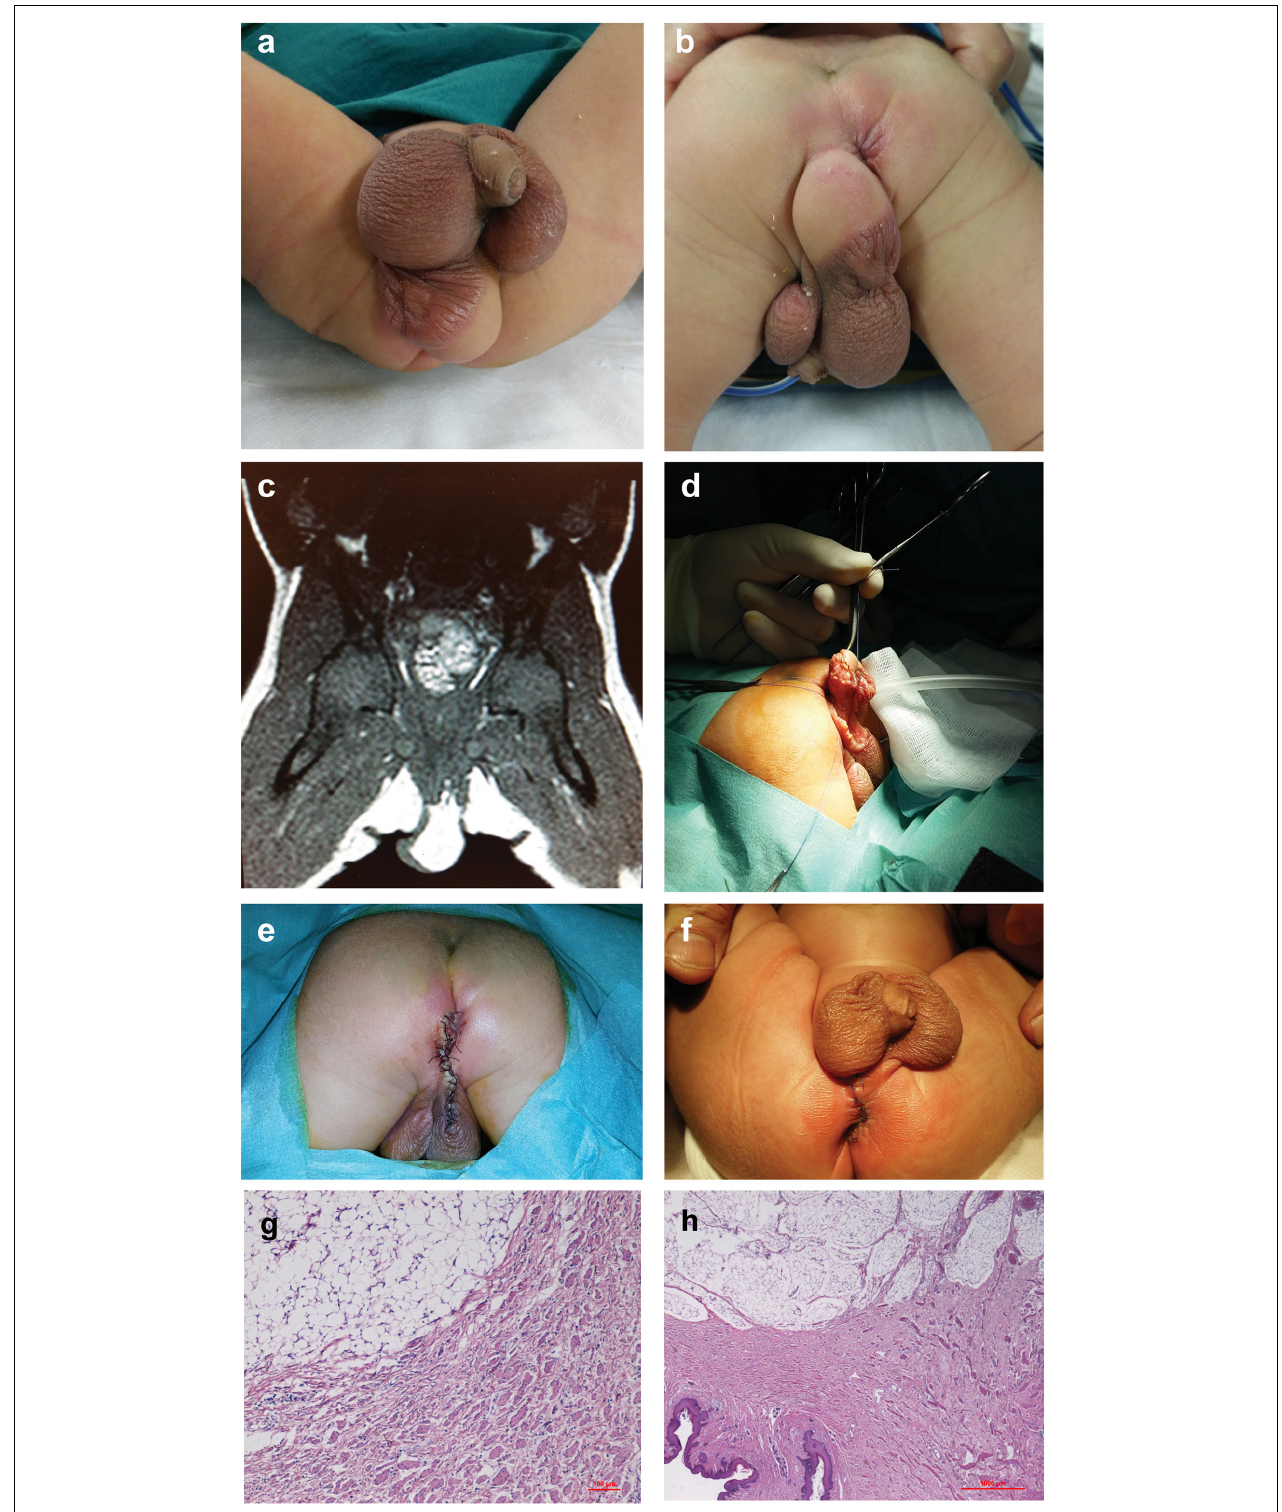
FIGURE 1 | Case 1. (a,b) Soft and spherical mass under the right hemiscrotum, with rugated pigmented scrotal skin on its upper part associated with incomplete penoscrotal transposition and right penoscrotal fusion. (c) Abdominal MRI: exophytic adipose tissue mass. (d) Surgery: excision of the mass and (e) perineal closure through interrupted resorbable stitches. (f) One-month follow-up. (g,h) Histological examination of specimens showing an area characterized by smooth muscle bundles dispersed in dermal collagen and a contiguous area with an abundant mature adipose tissue in the deep dermis and hypodermis.